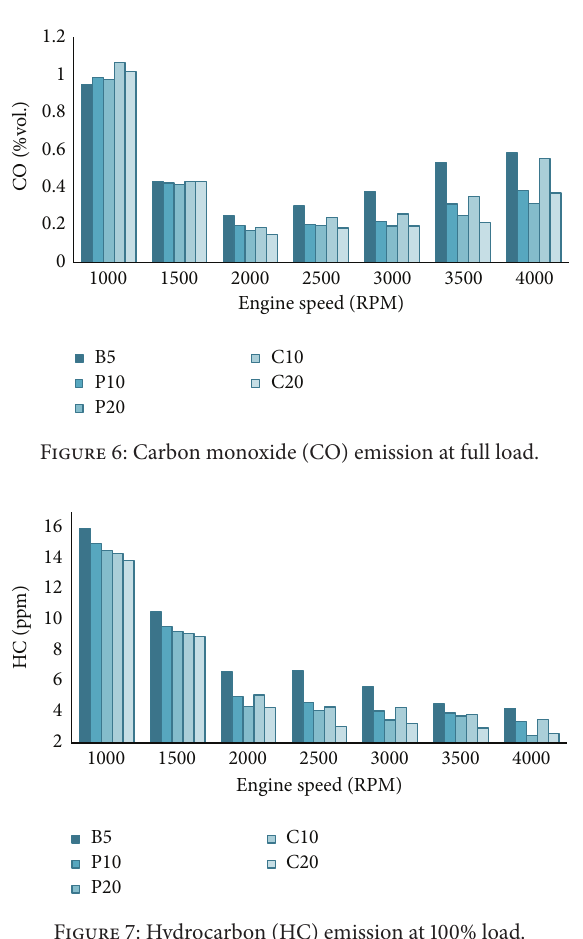
Figure 7: Hydrocarbon (HC) emission at 100% load.